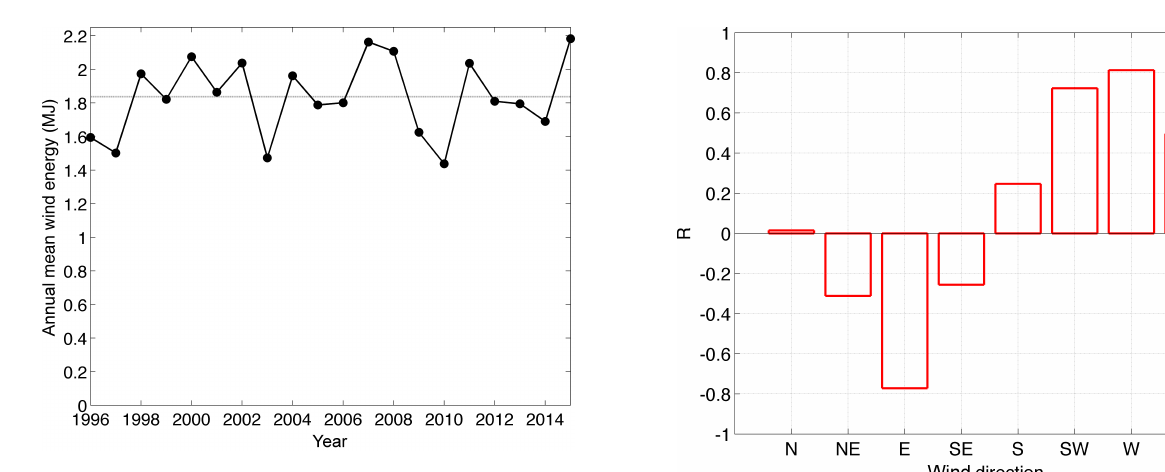
Figure 5. Annual mean wind energy summed over all eight sectors, at Vlieland weather station. The 20-year mean is indicated by the horizontal grey line.